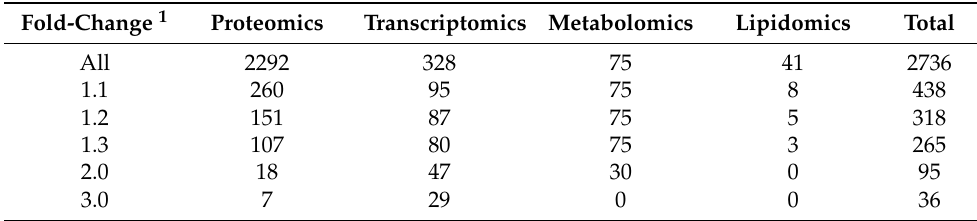
Table 1. Summary of feature numbers in each omics dataset as a function o.f cutoff value. Total numbers of features/molecules identified in all samples (without exception) obtained from high-risk T1D and healthy subjects ( n = 4 each), and numbers of remaining features after data selection using different fold-change cutoff